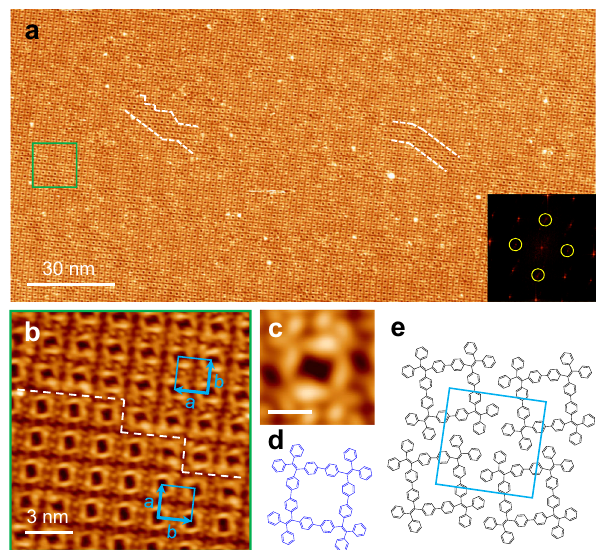
Fig. 3 Four-membered TPE macrocycles (M4) formed on Ag(111). a Large-scale STM image (200 nm × 100 nm; 2.0 V, 100 pA) of the 2D crystalline monolayer made of four-membered macrocycles (M4). Inset: FFT pattern. The dashed white lines indicate several domain boundaries. b Zoom in STM image (2.0 V, 200 pA) of the M4 2D crystal with a domain boundary (dashed line). The blue rectangles denote the unit cell of the 90° rotated domains. c , d High-resolution STM image ( − 1.0 V, 150 pA) and chemical model of M4. Scale bar: 1 nm. e Schematic model of the M4 2D crystal.